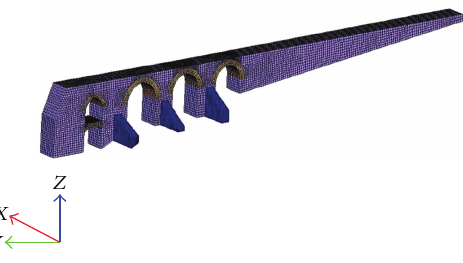
Figure 6: 3D FE model of Vezir aqueduct.